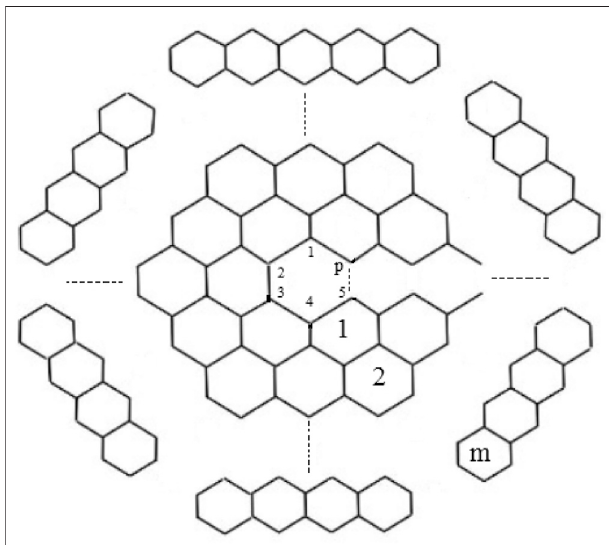
FIGURE 1 | CNC p [ m ].